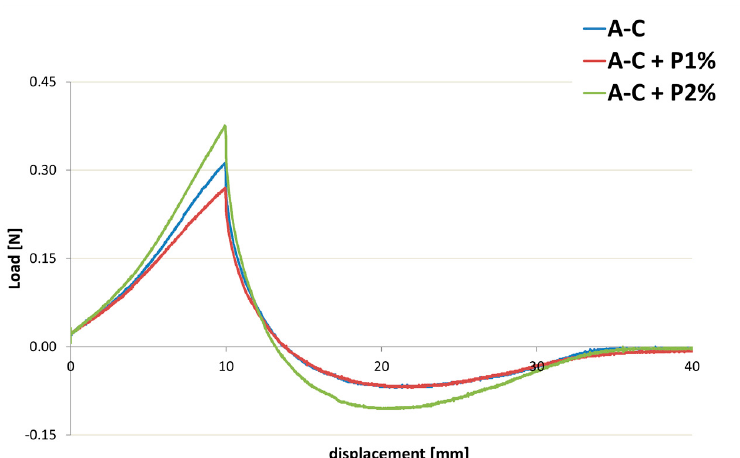
Figure 16. Textural parameters of adhesiveness ( a ) and stringiness ( b ) measured by an immersion/de-immersion test for the samples prepared with A–C associations at different ratios (1:0, 3:1, 2:1, 3:2, 0:1) at 1.5% w/w of the total polymer amount.